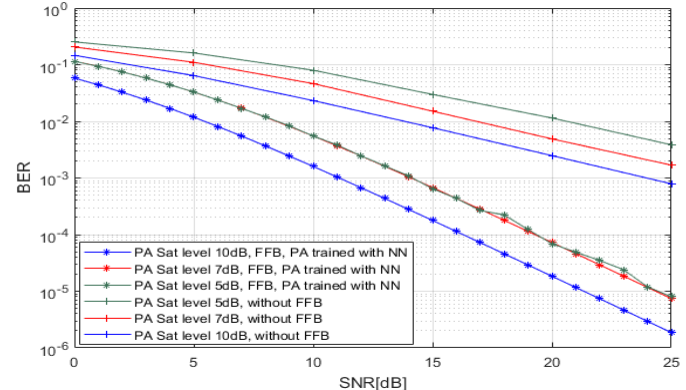
Figure 12. Bit error rate vs. SNR for FFB, distortion with PA nonlinearity and PA saturation levels of 10, 7, and 5 dB.